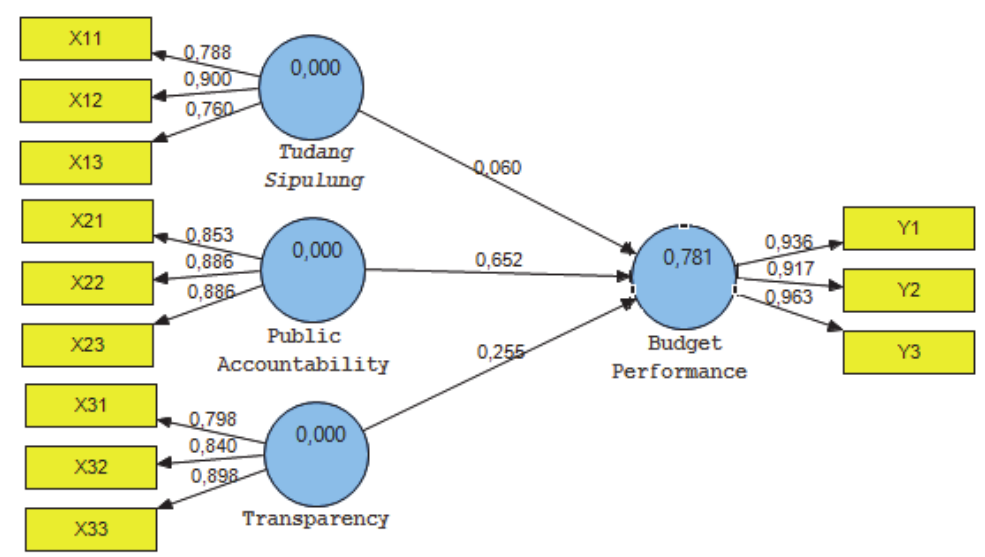
Fig. 2. SEM-PLS Measurement Model (Outer Model)